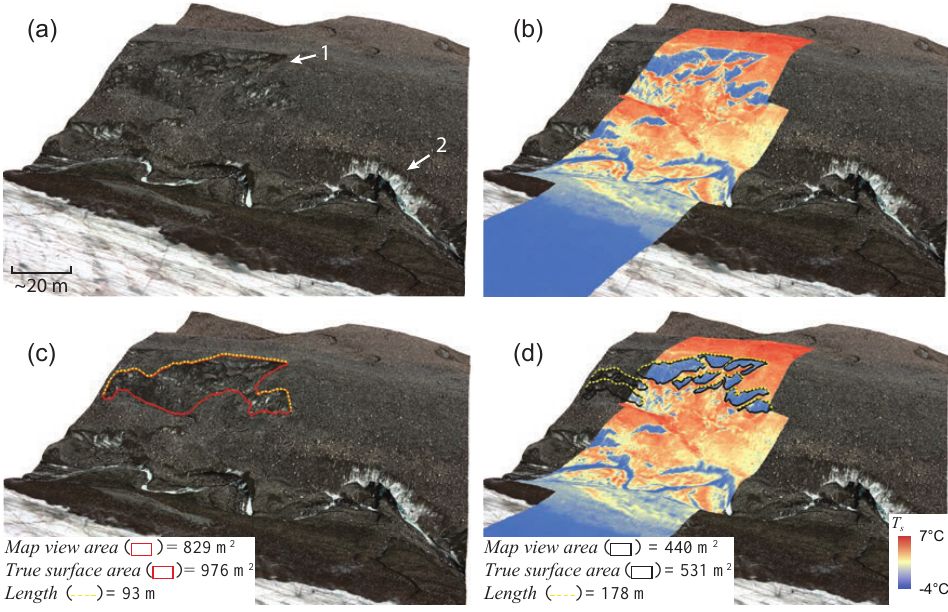
Figure 11. “1” and “2” in panel (a) show a less obvious and a very obvious ice cliff, respectively. When high-resolution surface temperature ( T s ) data is draped over ice cliff “1” in panel (b) , it becomes very apparent. Panels (c) and (d) demonstrate two common methods for mapping ice cliffs: by area and by tracing the top edge. Bare ice T s values below 0 ◦ C are likely due to camera calibration error and/or assuming a constant emissivity for the entire